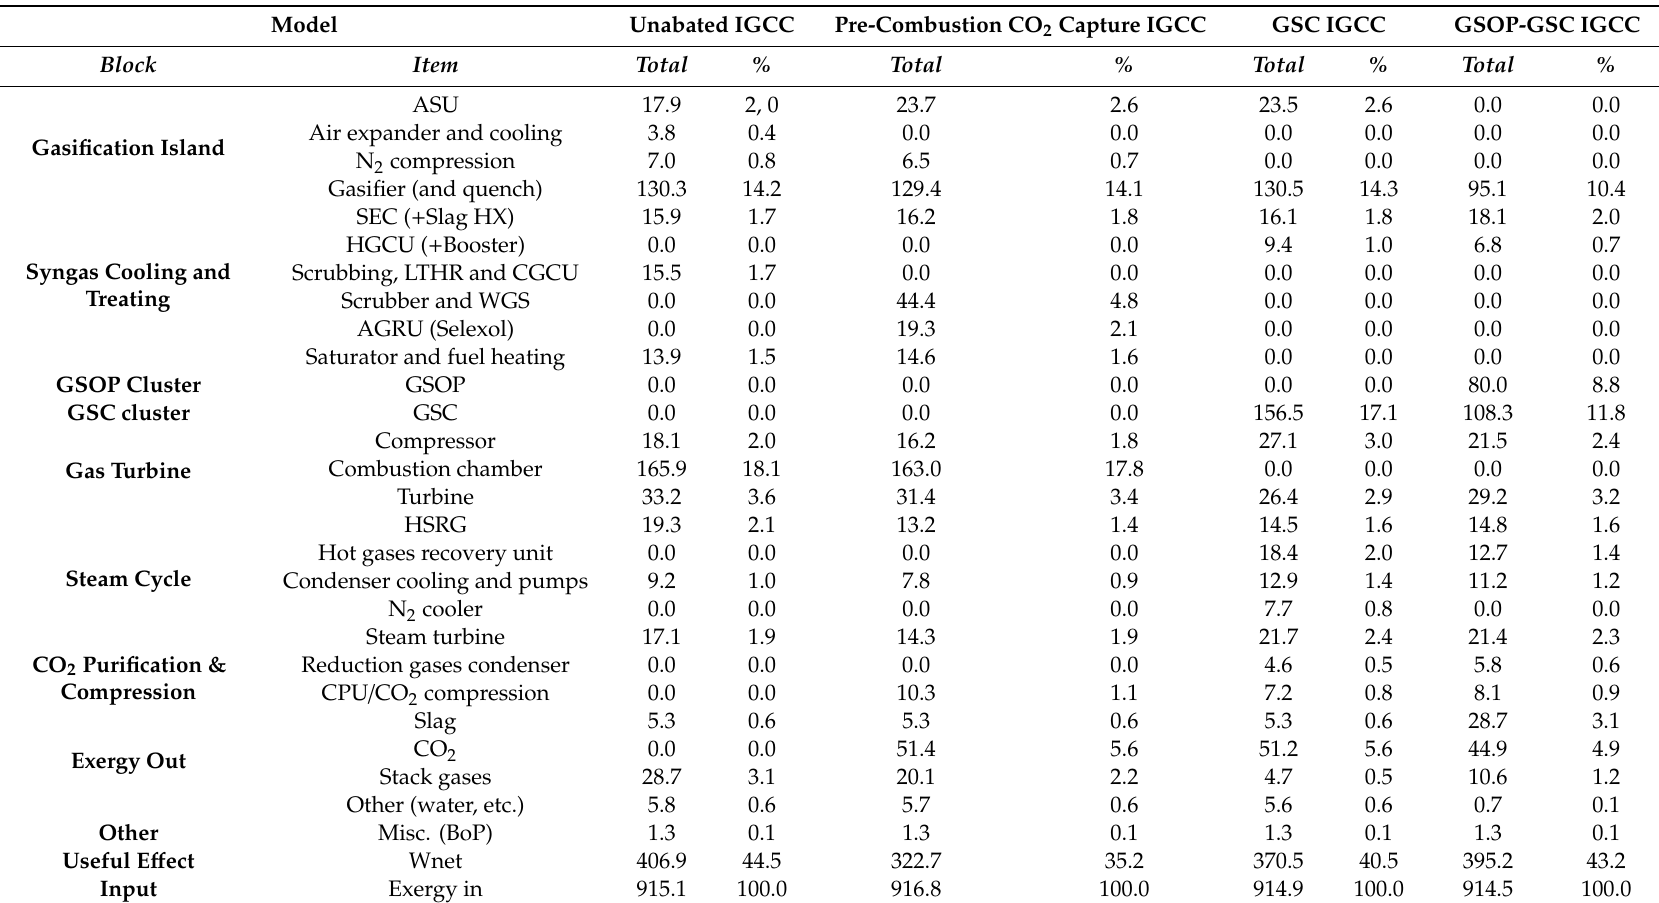
Table A6. Exergy balance per item of the di ff erent power plant models. Total values are in